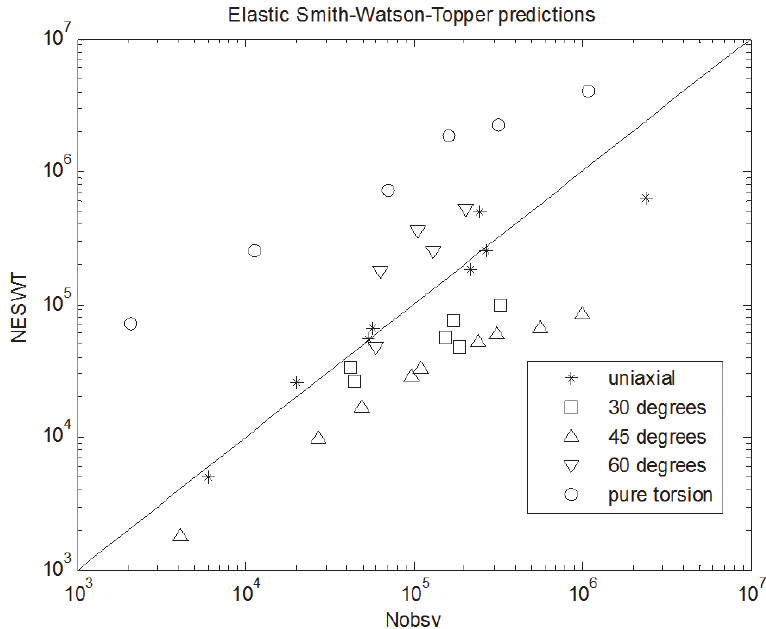
Figure 2: Comparison between the observed fatigue lives N obsv and the predicted N ESWT .